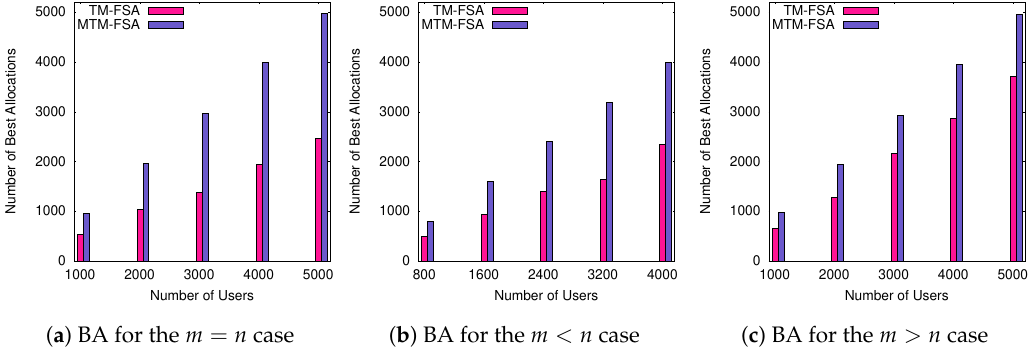
Figure 10. Comparison of TM-FSA and MTM-FSA based on the number of best